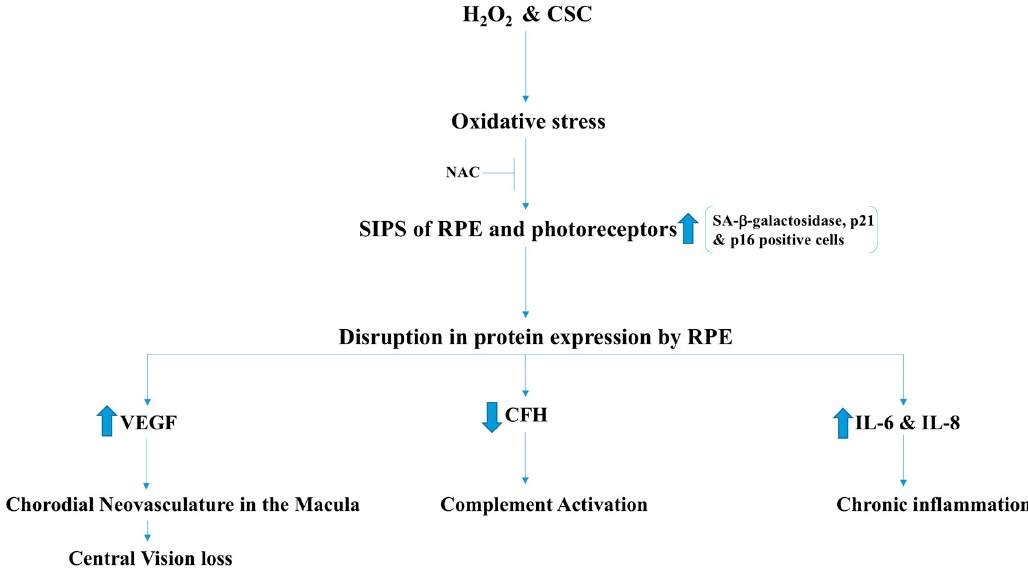
Figure 8. ROS-induced inflammation and damage to retinal pigmented epithelium (RPE) results in the activation of VEGF-induced choroidal neovasculature and Age-Related Macular Degeneration (AMD). Oxidative stress, including cigarette smoke and other inflammatory mediators, result in inflammatory damages to RPE, which, in turn, results in increase in vascular endothelial growth factor (VEGF), interlukine-6 (IL-6), interlukine-8 (IL-8), and activation of complement. These inflammatory mediators and endothelial growth factors induce a chronic inflammatory state including neovessel formation in the Macula, a hallmark of AMD. CSC: Cigarrete smoke concentrate; SIPS: stress-induced premature cellular senescence; CFH: complement factor NAC: N-acetylcysteine; SIPS: stress-induced premature cellular senescence; CFH: complement factor H.